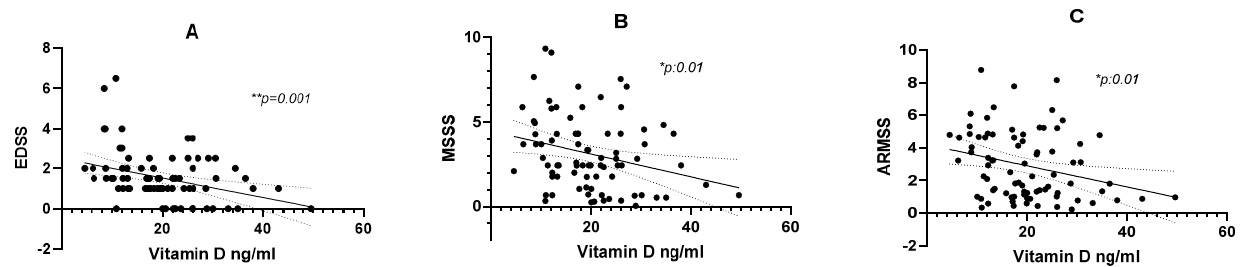
Figure 3. Correlation between serum vitamin D and EDSS ( A ), MSSS ( B ), and ARMSS ( C ). Vitamin D was statistically